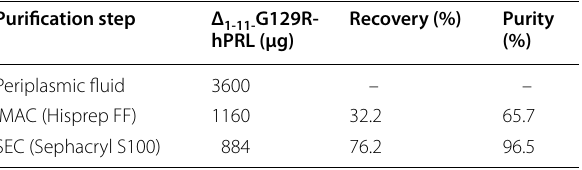
-G129R-hPRL after 1-11